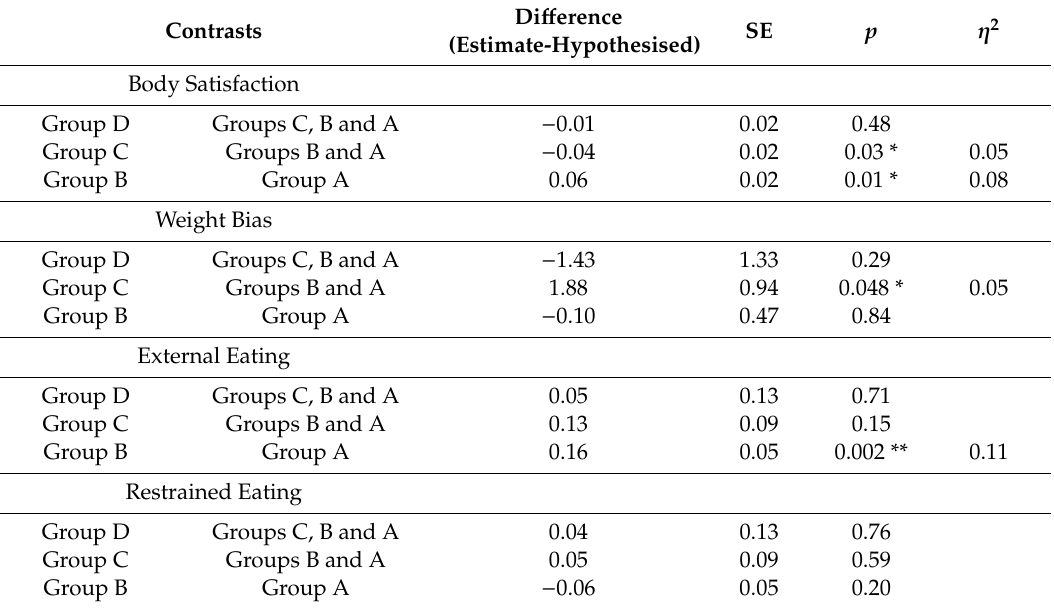
Table 2. Results of planned orthogonal contrasts on child outcome